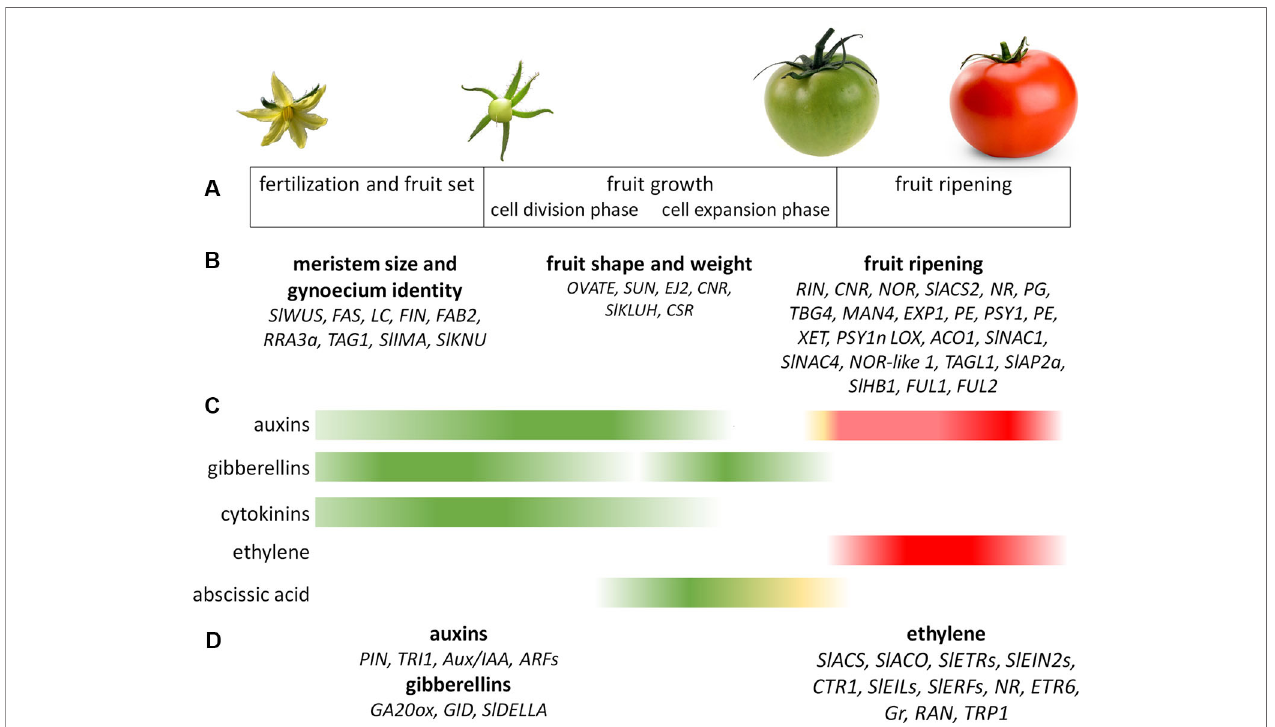
FIGURE 1 | Genetic and hormonal control of tomato fruit development. (A) Main stages of tomato fruit development. (B) Genes involved in the control of tomato fruit development that are mentioned in this article. (C) Main hormones involved in tomato fruit development during fruit set and fruit growth (green) and fruit ripening (red). (D) Genes involved in the hormonal regulation of fruit development that are mentioned in this article. The Figure summarizes data collected by Gillaspy et al. (1993); Srivastava and Handa (2005); Karlova et al. (2014) and Obroucheva